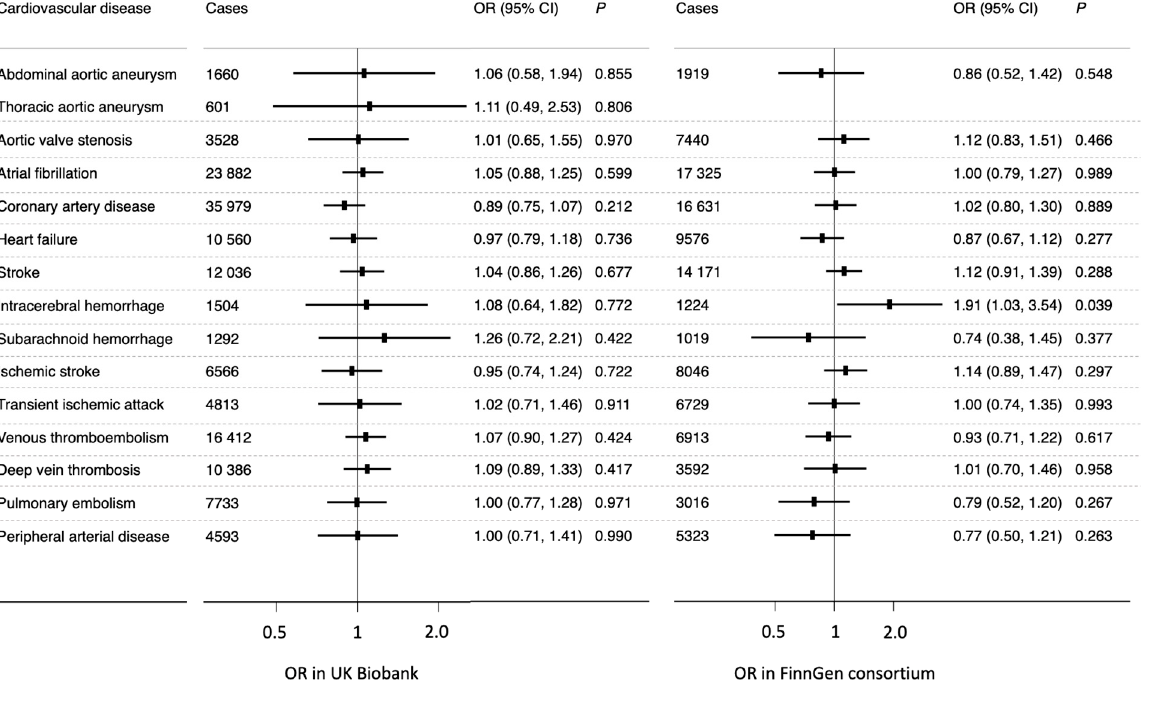
Figure 2. Associations of genetically predicted coffee consumption with cardiovascular diseases in multivariable MR analysis with adjustment for genetically predicted BMI and smoking initiation. CI indicates confidence interval; OR, odds ratio. Aortic aneurysm includes abdominal and thoracic aortic aneurysm in FinnGen. Data for non-rheumatic valve diseases were used in FinnGen to replicate the association for aortic valve stenosis in UK